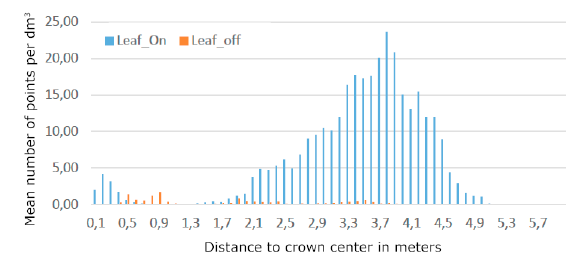
Figure 4. Mean point density per 5x1 dm 3 in various distances to the crown centre in level 6 - 6,5 m height.